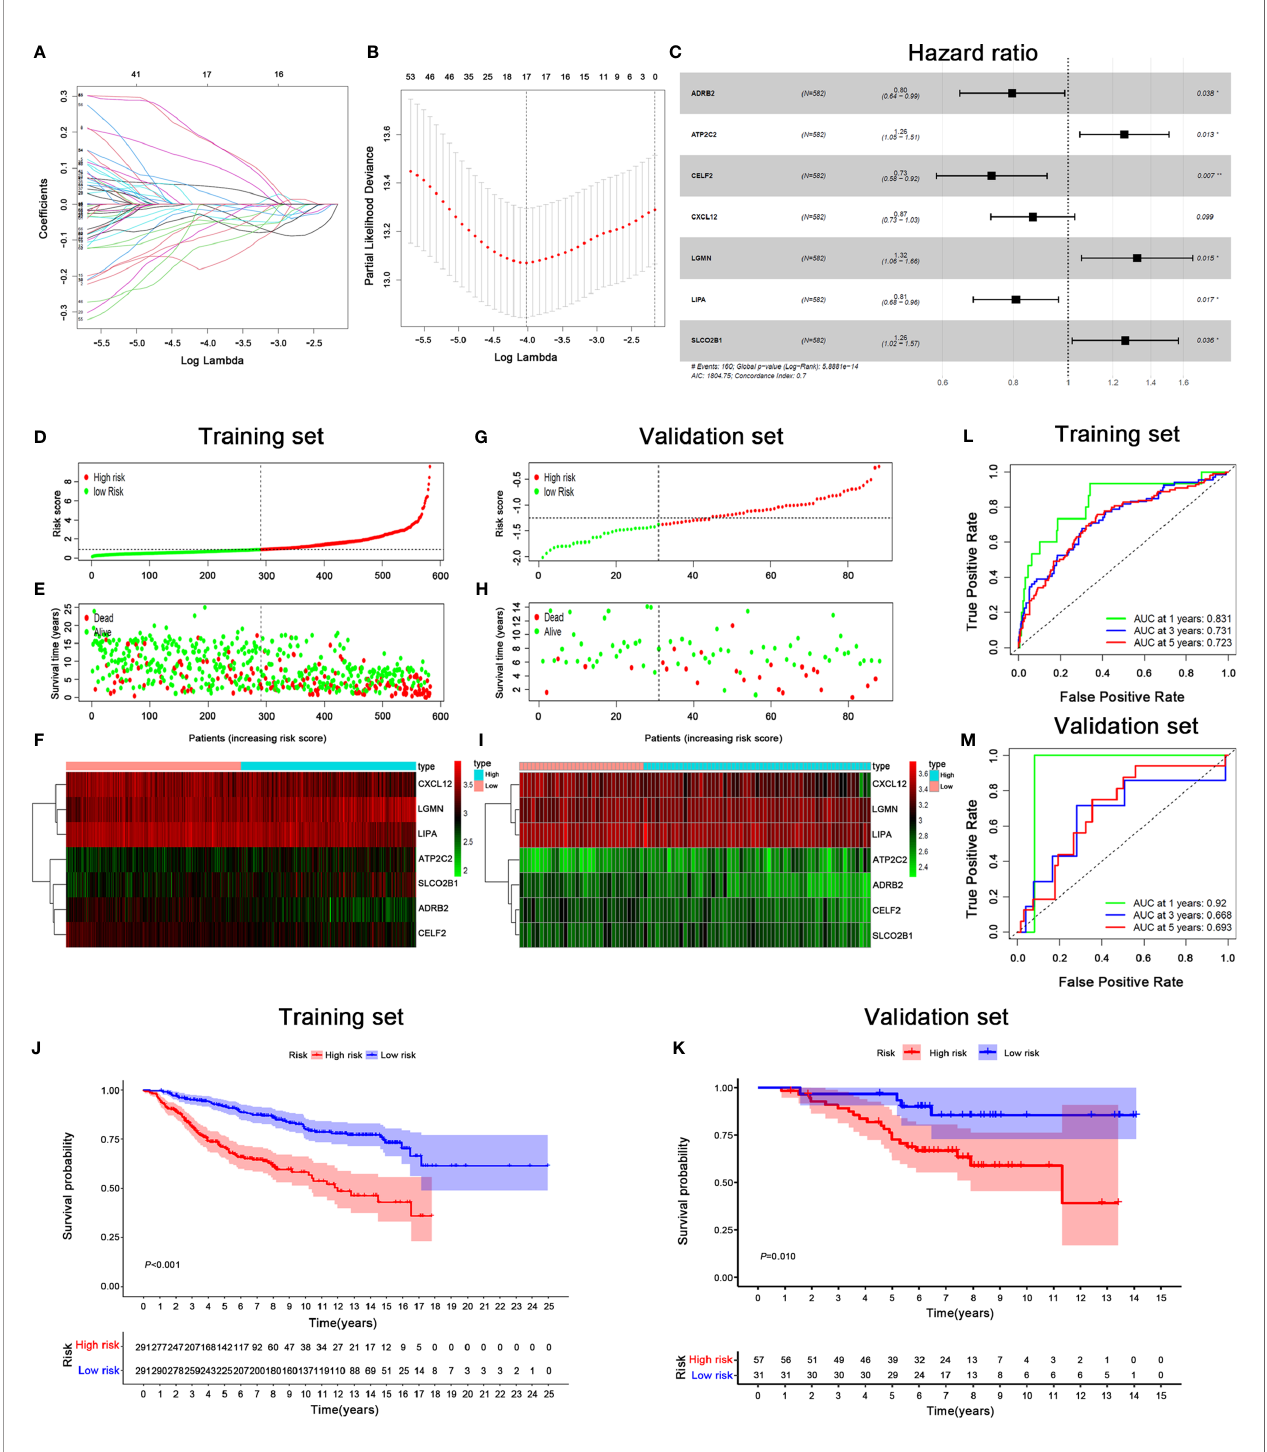
FIGURE 3 | Signature-based risk score is a promising marker of survival in BRCA patients. (A, B) LASSO Cox analysis identi fi ed seven genes most correlated with OS, and 10-round cross validation was performed to prevent over fi tting. (C) Multivariate Cox analysis of 7 immune-related hub genes. (D, G) Risk score distribution in training set (D) and validation set (G) . (E, H) Survival overview in training set (E) and validation set (H) . (F, I) Expression pro fi le of 7 immune genes in training set (F) and validation set (I) . (J, K) Kaplan – Meier estimates of OS according to the seven-immune-related gene signature in training set (J) and validation set (K) . The differences between the two curves were evaluated by the two-side log-rank test. (L, M) The ROC curve analysis of the seven-immune-related gene signature for predicting OS in training set (L) and validation set (M)